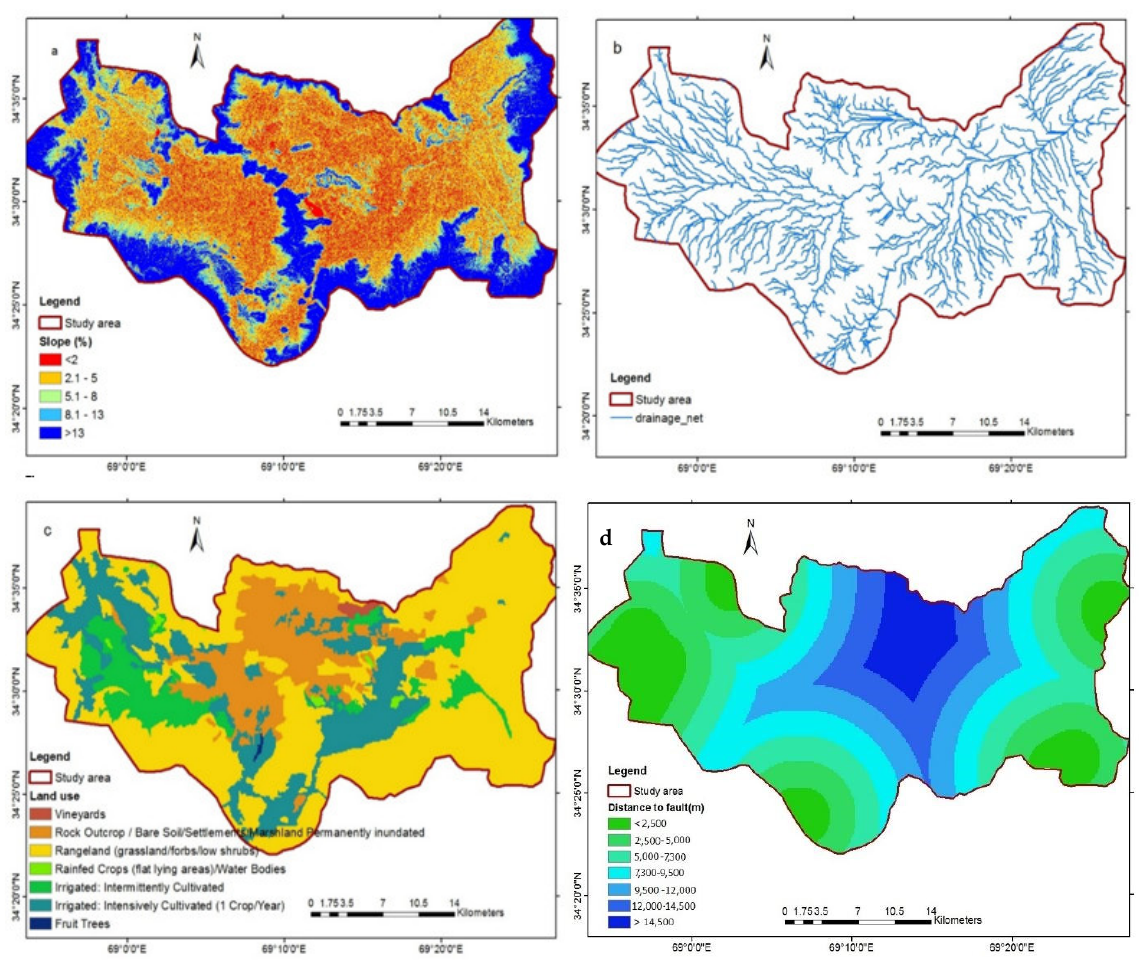
Figure 3. Maps of the remote sensing data: ( a ) slope; ( b ) drainage density; ( c ) land use; ( d ) distance to fault.